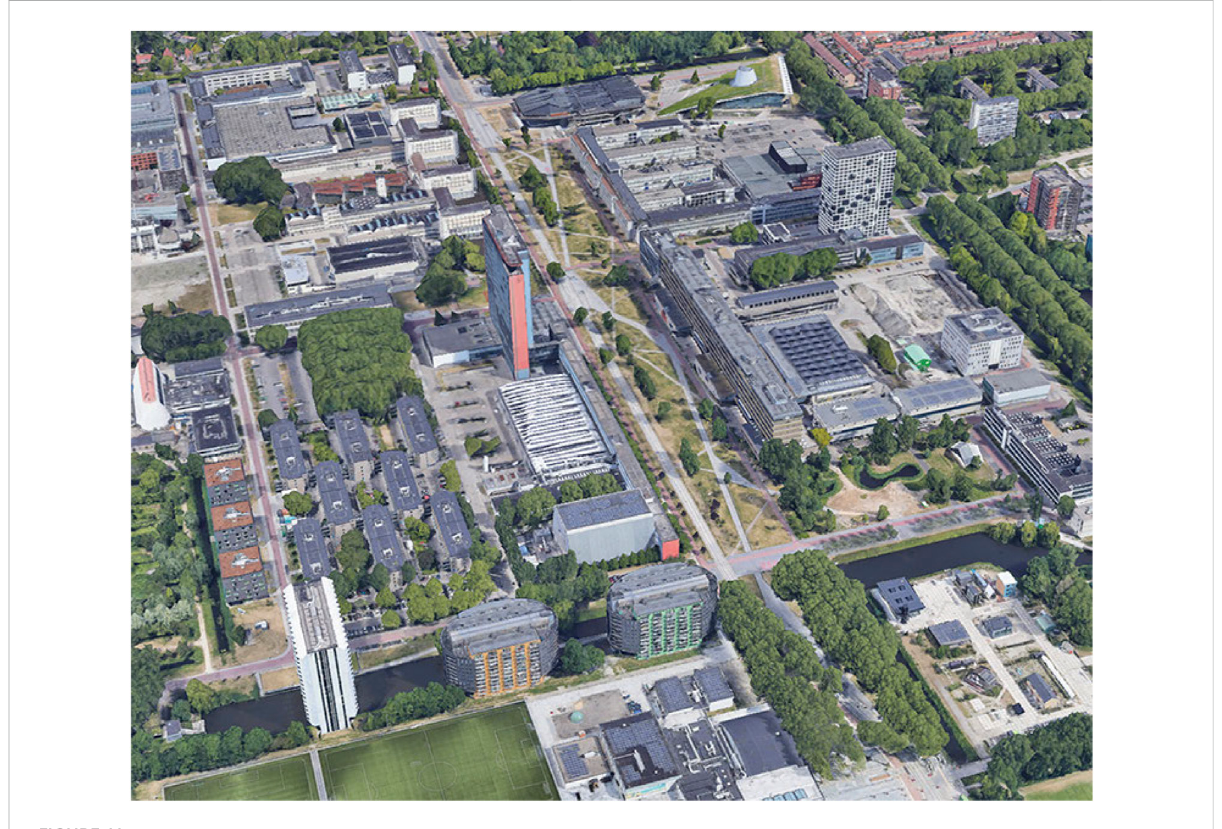
FIGURE 11 Google Earth imagery (Google, 2022) of the TUD Campus.